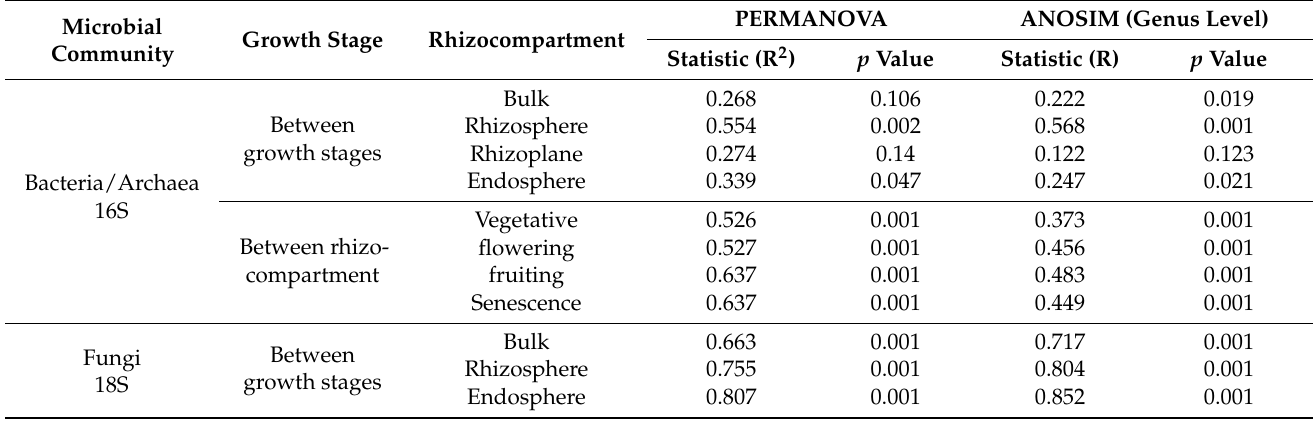
Table 1. ANOSIM and PERMANOVA analysis between the rhizocompartments and growth stages of bacterial and fungal